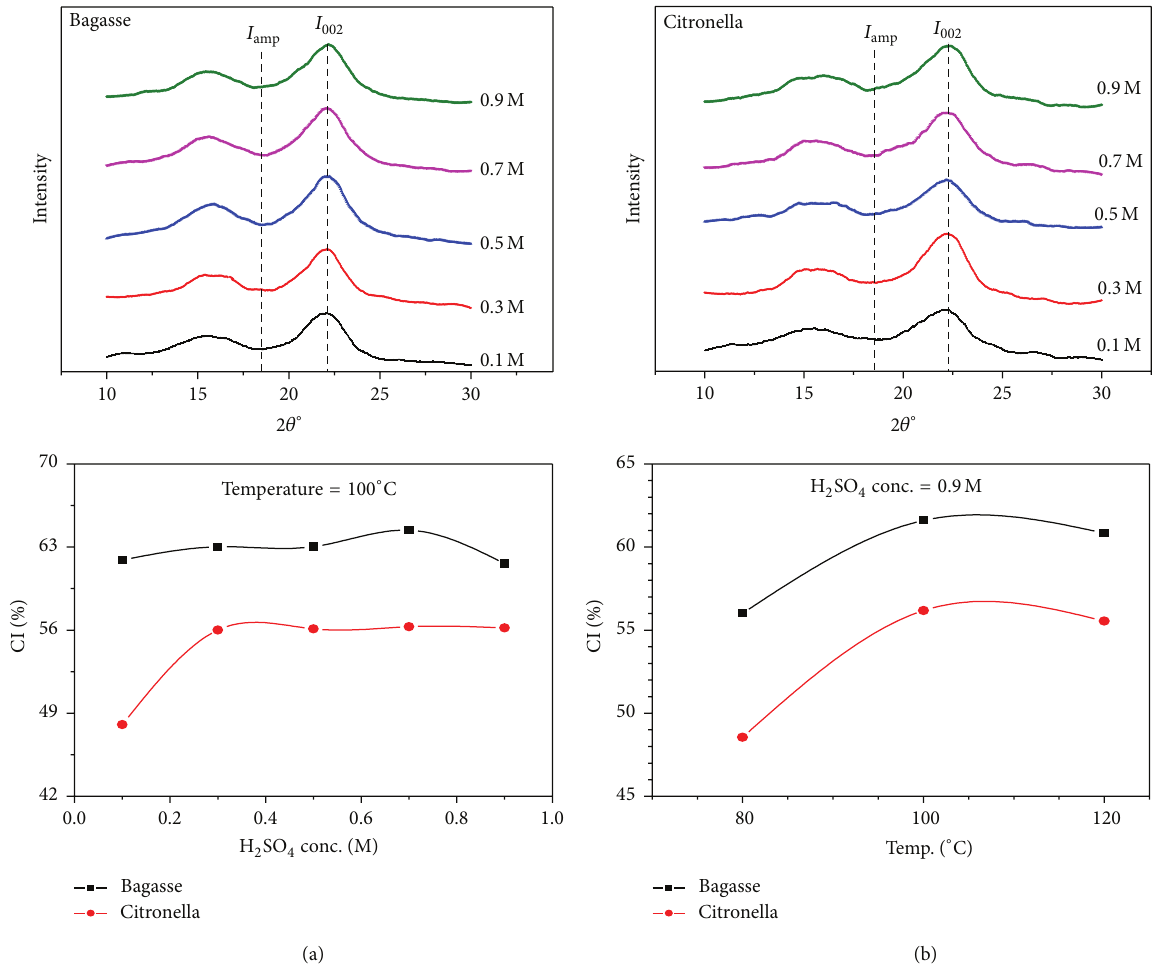
Figure 6: XRD analysis of acid pretreated biomass at (a) different H 2 SO 4 concentration at 100 ∘ C and (b) different temperature at 0.9M H 2 SO 4